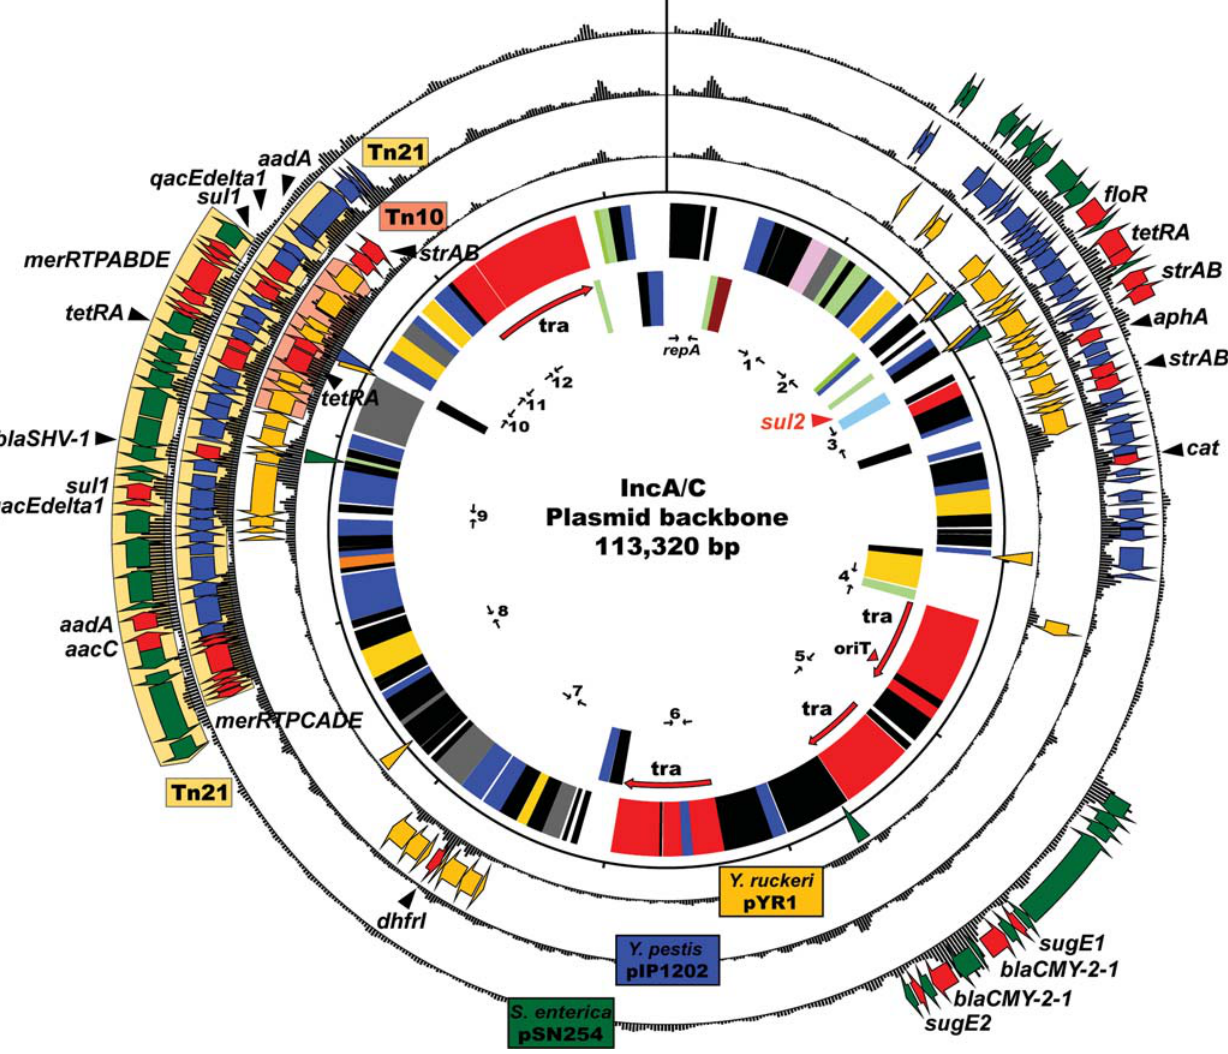
Figure 1. Circular representation of the IncA/C backbone (inner circle) and laterally acquired regions (outer circles) on each of the three plasmids. Nucleotide composition is represented on each of the outer circles and PCR primers used in this study are indicated in the inner circle. Antimicrobial determinants are colored red and labeled with gene names as follows: sulfonamides ( sul1, sul2 ); phenicols ( cat, floR ); tetracyclines ( tetRA ); aminoglycosides/aminocyclitols ( aacC, aadA, aphA, strAB ); quaternary ammonium compounds ( qacEdelta1, sugE1, sugE2 ); b -lactams ( blaCMY- 2-1, blaCMY-2-2, blaSHV-1 ); trimethoprim ( dhfrI ); mercury ions ( merRTPABDE, merRTPCADE ). Sequences described in this manuscript have been deposited in GenBank, accession numbers are CP000603 (pIP1202), CP000604 (pSN254), CP000602